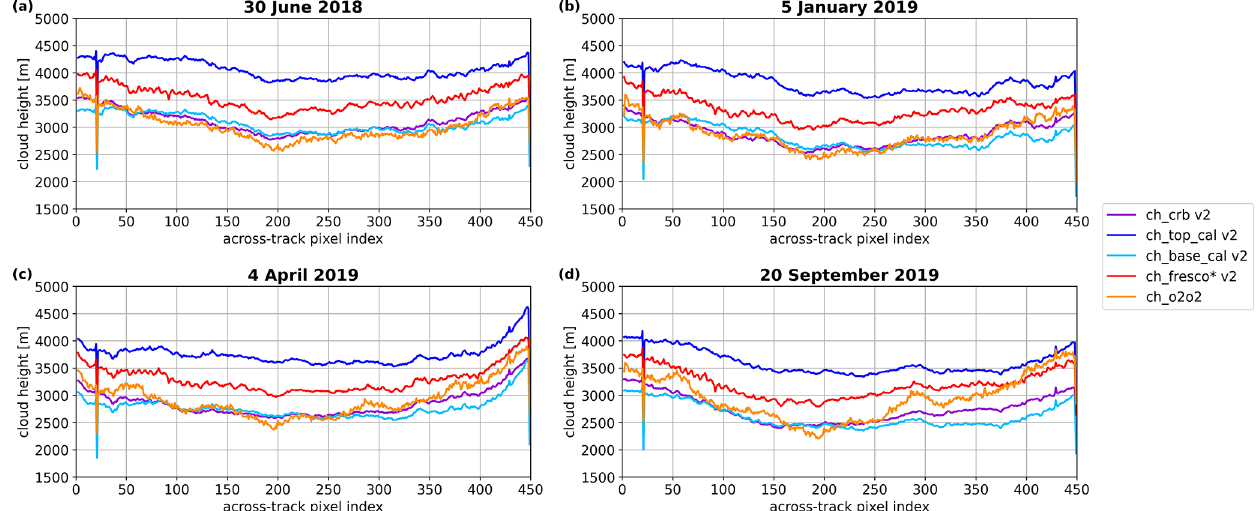
Figure 18. Mean values of version 2 cloud heights, as a function of the across-track index, from ROCINN CRB, ROCINN CAL top and base, FRESCO from the TROPOMI NO 2 product (ch_fresco*), and O 2 –O 2 for the globe and (a) the summer day, (b) the winter day, (c) the spring day, and (d) the autumn day with quality, snow, and ice flagging and only including pixels that have valid values for all products.